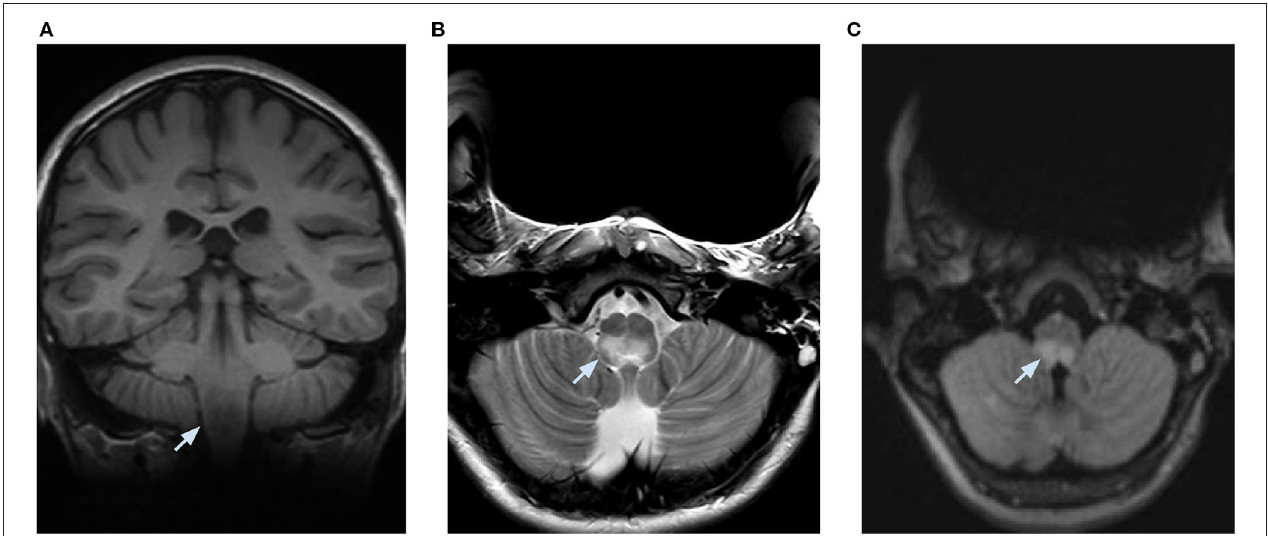
FIGURE 2 | Brain MRI performed at 1.5 Tesla and limited by metallic artifacts. (A) coronal T1 weighted imaging showing a low signal intensity, (B) axial T2 weighted imaging, and (C) axial fluid attenuation inversion recovery showing a high signal intensity in the posterior part of the medulla oblongata